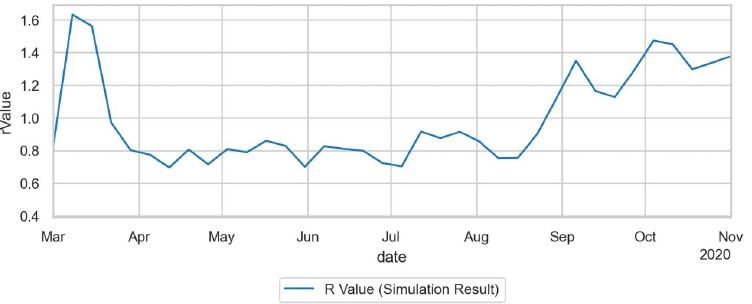
Fig 14. Reproduction number R ( t ) for the duration of the simulation. As explained in the text, we explicitly count the reproduction number per agent, and then average them over all agents that turned contagious on a given day.